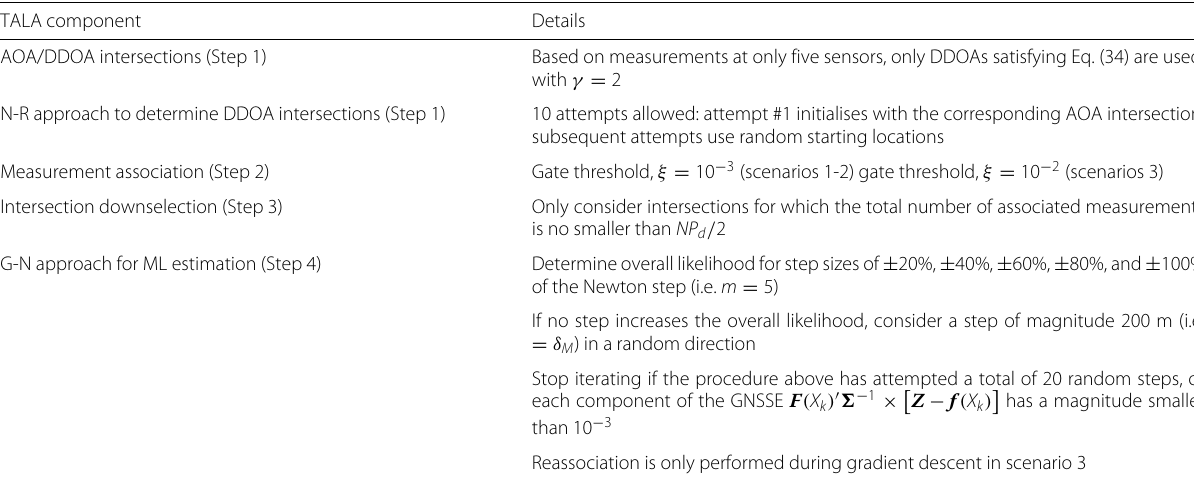
Table 2 Summary of TALA settings TALA component Details AOA/DDOA intersections (Step